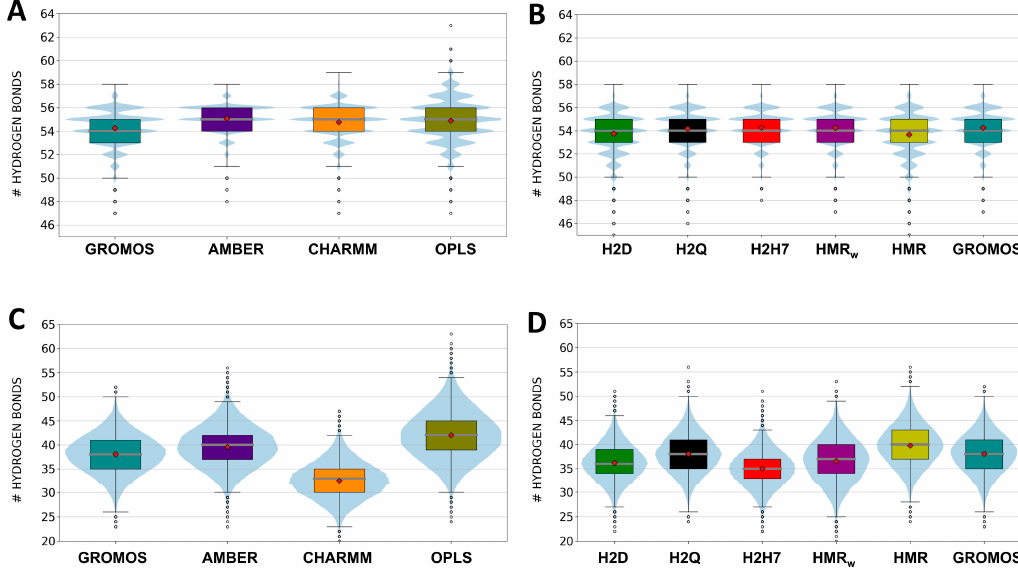
Figure 6. Numbers of H-bonds between CP subunits ( A , B ) and between the CPs and water ( C , D ), for the unmodified force fields ( A , C ), and for the modified parameterizations of GROMOS ( B , D ), based on the HMR and HIE methods. The grey line represents the median and the red diamond represents the mean of the distributions. The size of the boxes includes data within the second and third quartiles, so that 50% of the data are within the corresponding box. The whiskers, calculated following Tukey’s criteria [46], include data on the first and fourth quartiles. Together with the boxplot representation, the distribution of the number of H-bonds is represented by the shadows.